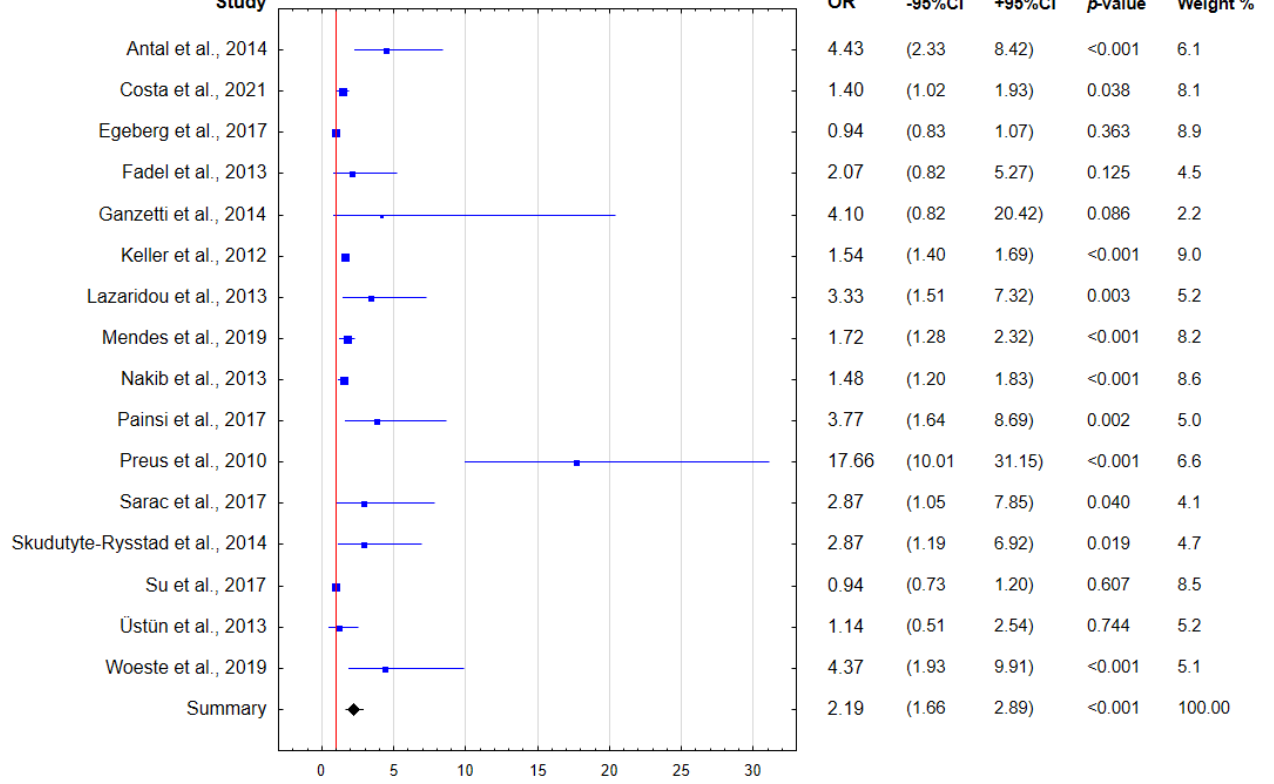
Figure 4. Forest plot presenting the odds for periodontal disease in patients with psoriasis (OR: odds ratio; CI: confidence interval) [33–35,40–52].